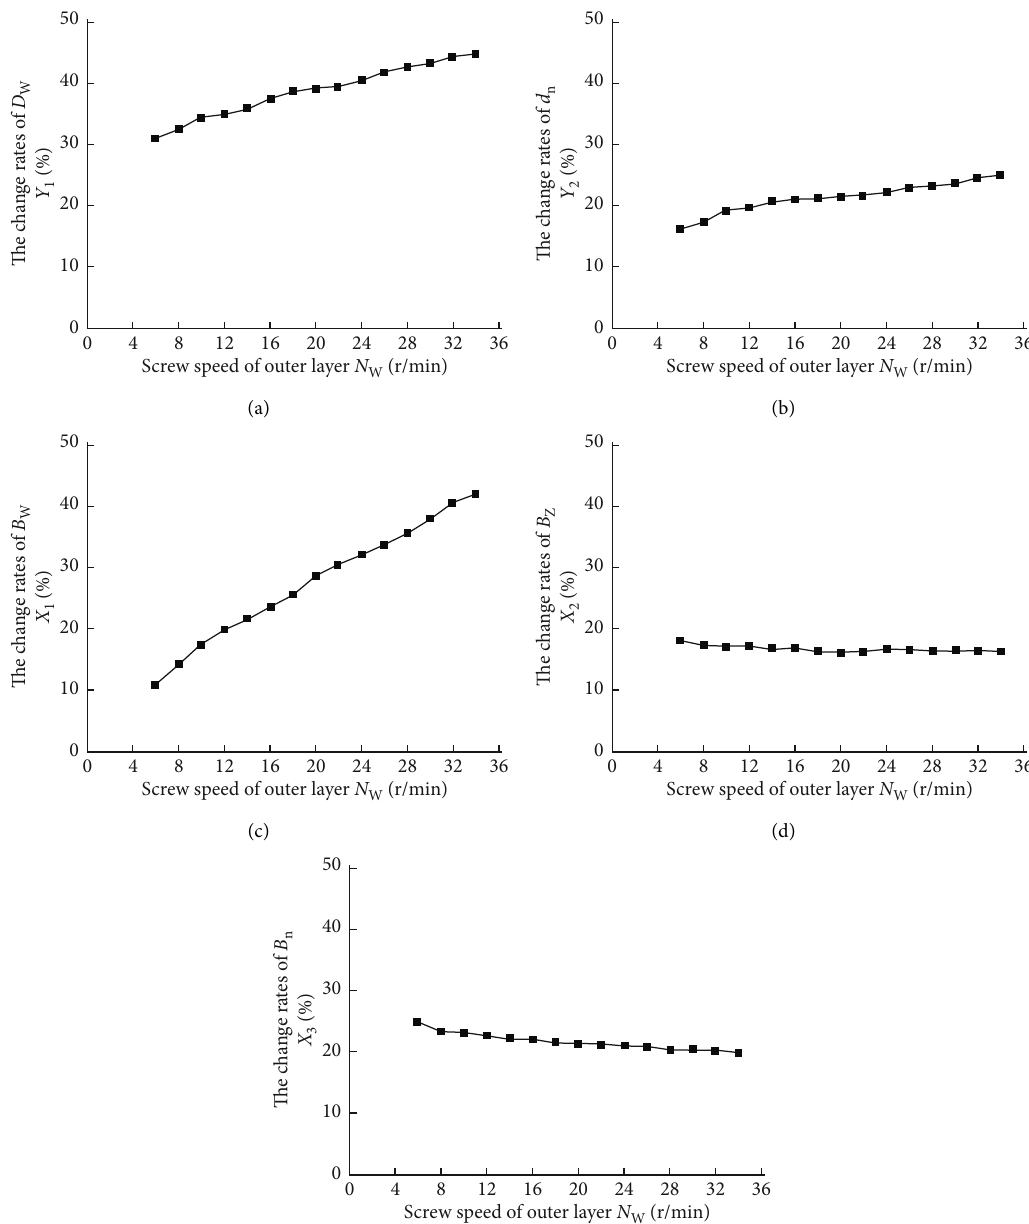
Figure 10: Diameter change rates ((a) outer and (b) inner diameter) and wall thickness change rates ((c) outer layer, (d) middle layer, and (e) inner layer wall thicknesses) of three-layered balloon catheters as a function of screw speed of the outer layer